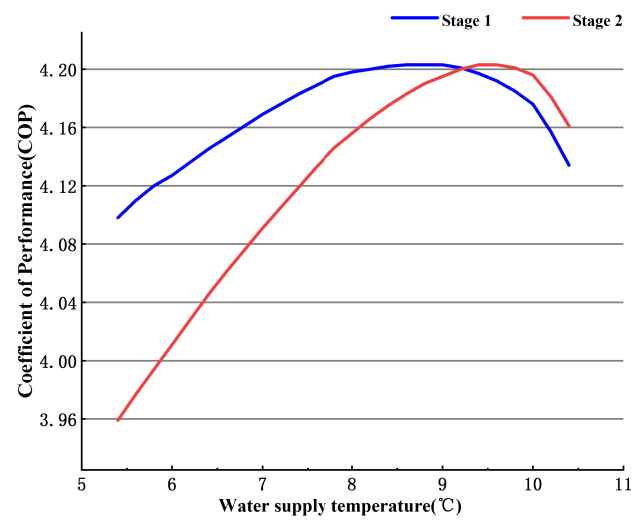
Figure 12. The changing law of COP under different chilled water supply temperatures in Stages 1